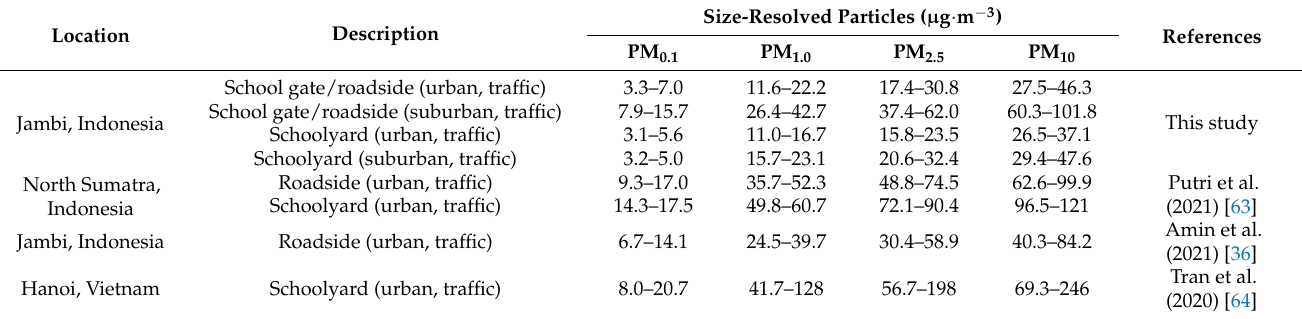
Table 3. Comparison of PM mass concentration related to school environments and roadsides in the present study and previous